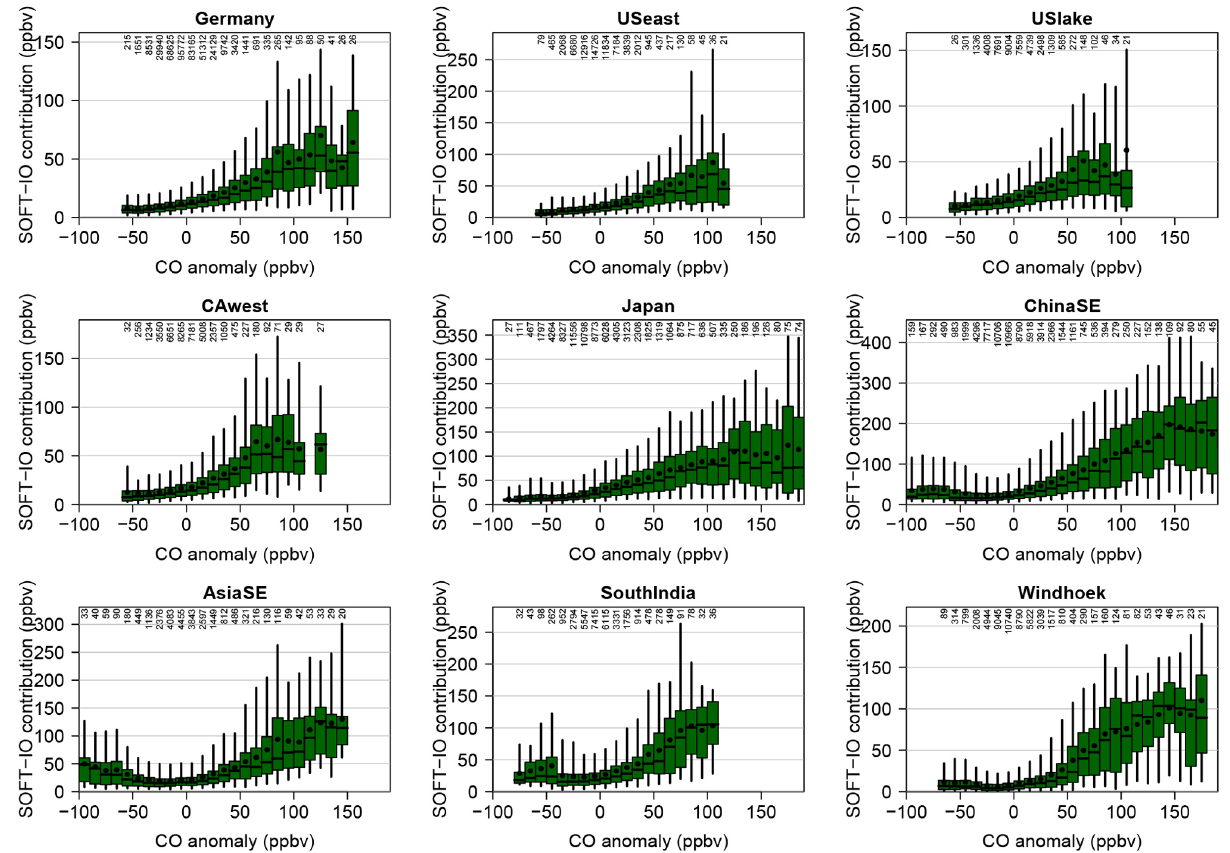
Figure 13. SOFT-IO total (C AN + BB ) contributions against observed CO anomalies. The box-and-whisker plot shows the 5th, 25th, 50th, 75th and 95th percentiles of the contributions; the black dot indicates the mean contribution. The number of points included is reported on the top of each panel. No distribution is plotted when this number is below 20. Table 4. Distribution of the CO anomalies (in ppbv) at the different airport clusters. Anomalies are defined as the departures from the seasonally averaged climatological vertical profile (see text). Airport cluster Percentile of CO mixing ratios anomalies (ppbv)